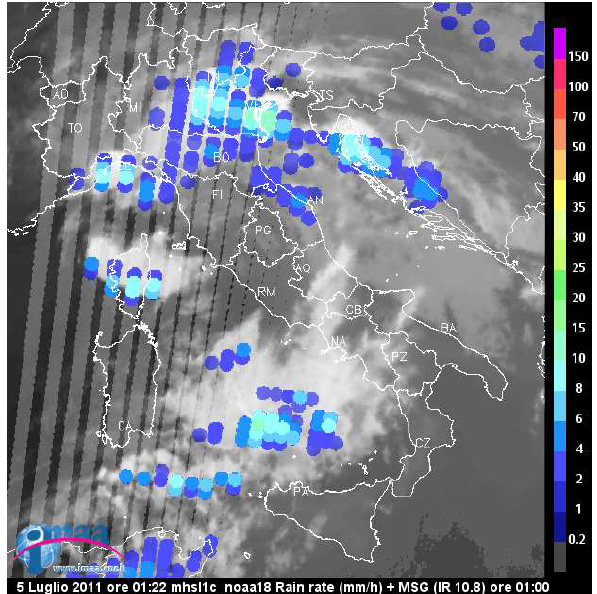
Figure 1: An example of the graphical output of OPEMW (the MHS FOVs are represented as 3 Fig. 1. An example of the graphical output of OPEMW (the MHS FOVs are represented as uniform circles along the scan line). uniform circles along the scan line). The surface rain intensity (sri) product is color-coded 4 The surface rain intensity (sri) product is color-coded according according to the vertical bar (in mm/h) and layered over the Meteosat Second Generation (MSG) 5 to the vertical bar (in mmh − 1 ) and layered over the Meteosat 10.8 m m image (in normalized inverted grey scale). Data obtained from MHS on NOAA N-18 6 Second Generation (MSG) 10.8µm image (in normalized inverted overpass at 01:22 UTC and MSG observations at 01:00 UTC on 5 July 2011. 7 greyscale). Data obtained from MHS on NOAA N-18 overpass at 01:22UTC and MSG observations at 01:00UTC on 5 July